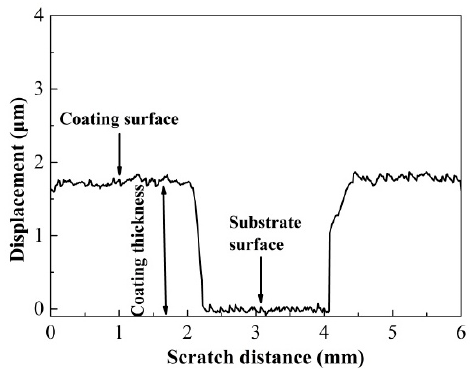
Figure 10. Coating thickness curve in scratch test with the Zr current of 30 A.